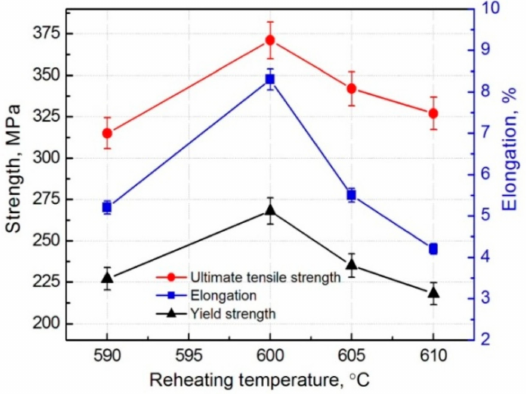
Figure 6. Variations of tensile properties of the composite vs reheating